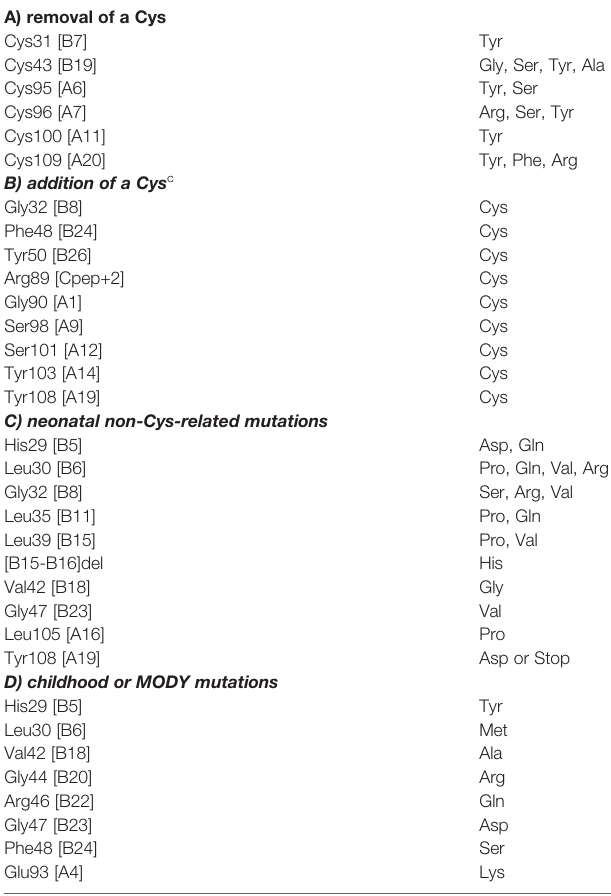
TABLE 1 | Sites of clinical mutations in proinsulin a,b